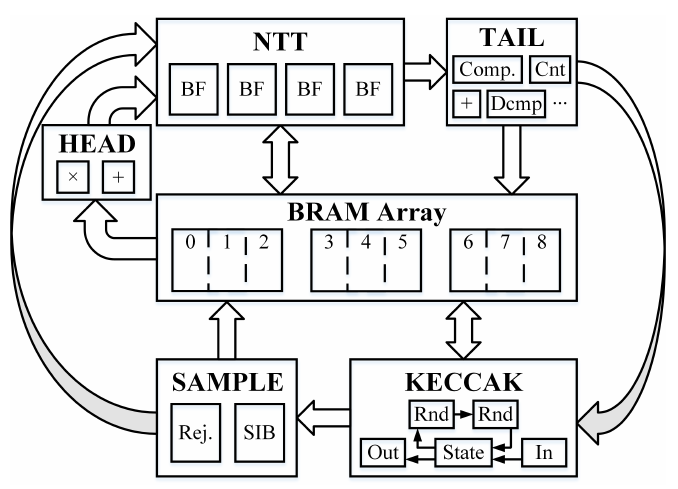
Figure 2: System